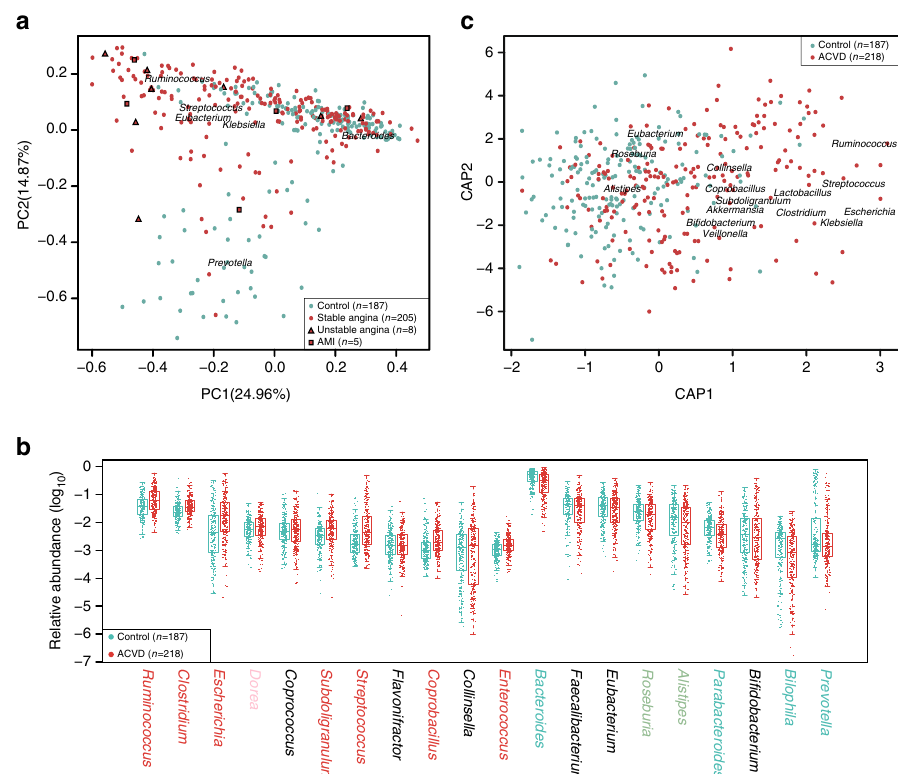
Fig. 1 Major genera in the ACVD gut microbiome. a PCA of genus-level ACVD gut microbiomes. Control samples, n = 187 ( cyan ); ACVD samples, n = 218 ( red ). For the ACVD samples (Supplementary Data 1), 205 were stable angina ( circles ), 8 were unstable angina ( triangles ), and 5 were acute myocardial infarction (AMI) ( squares ). Genera with the largest weights on each principal component are shown. b Relative abundances of the top 20 most abundant genera. The genus names were colored according to signi fi cant differences between the ACVD and control samples, i.e., red or cyan , q -value < 0.01; light red or green , q -value < 0.05; black , q -value ≥ 0.05, Wilcoxon rank-sum test, controlled for multiple testing. Boxes represent the median and interquartile ranges (IQRs) between the fi rst and third quartiles; whiskers represent the lowest or highest values within 1.5 times IQR from the fi rst or third quartiles. Circles represent all data points. c Differentially changed genera in ACVD and controls according to dbRDA based on Bray – Curtis distance. Genera with the largest weights on each principal coordinate are shown. CAP constrained analysis of principal